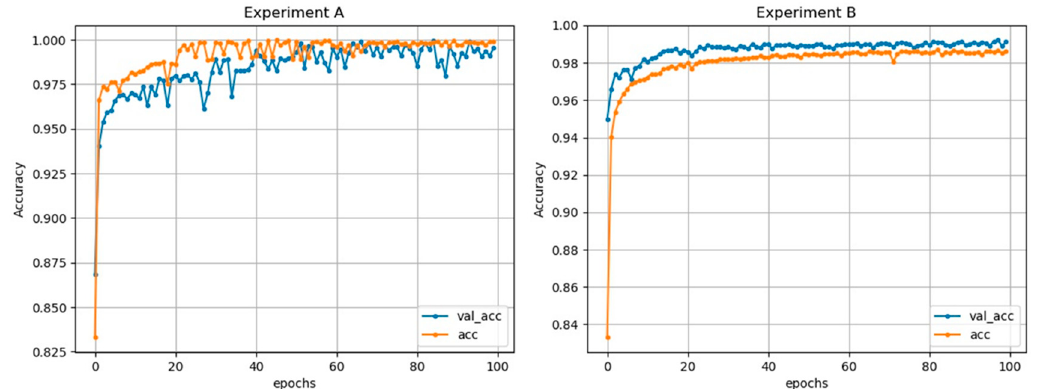
Figure 4. Accuracies of the two training models. Experiment A without dropout regularization. Experiment B with dropout regularization.